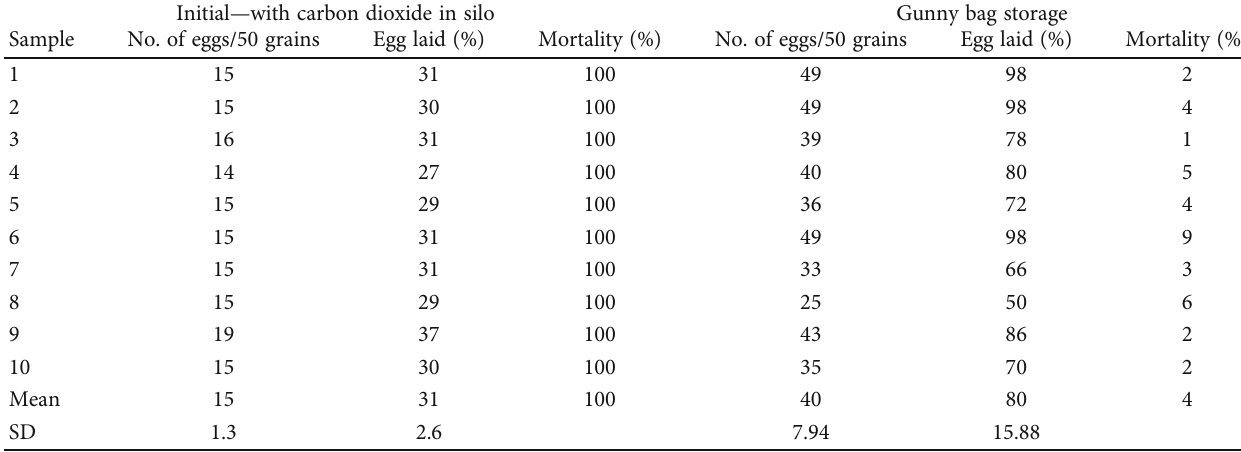
and gunny bag storage. 2